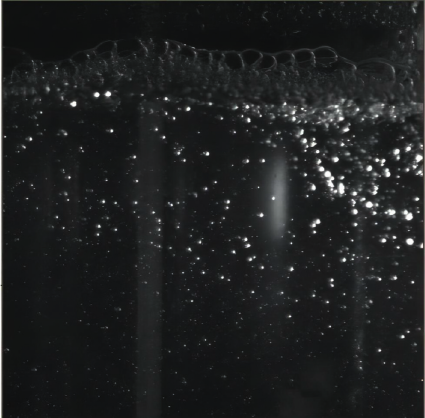
Figure 12: Photos taken by high-speed camera.